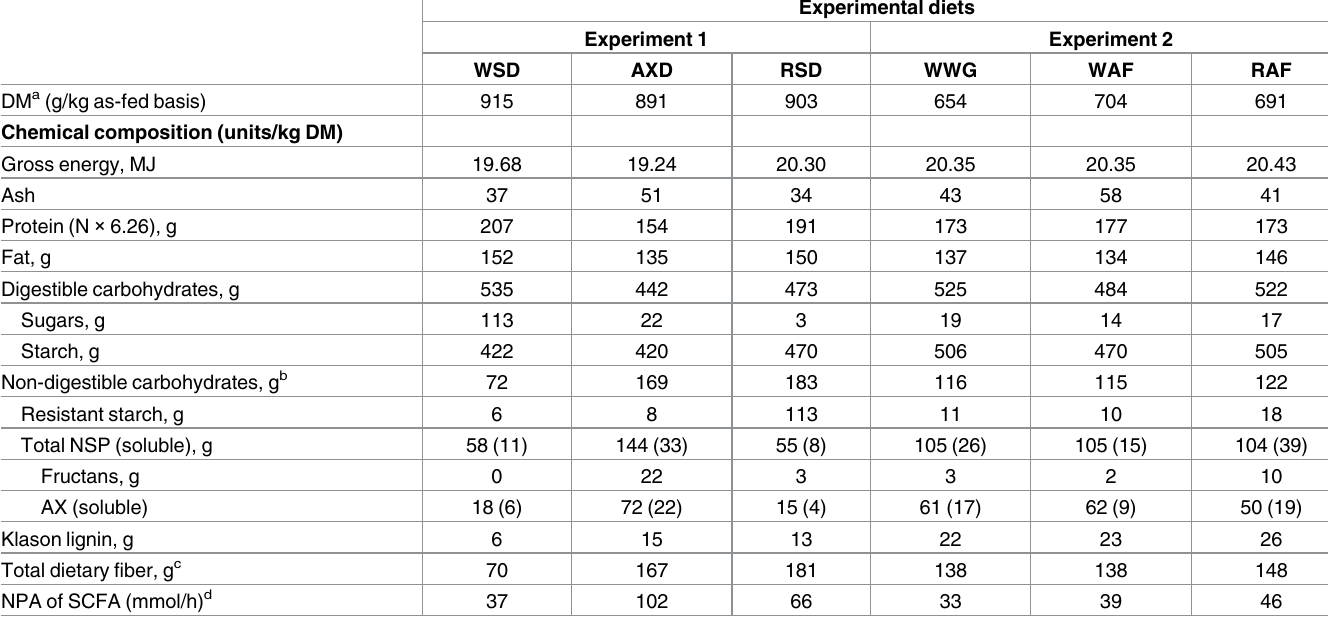
Table 1. Chemical composition of the experimental diets and postprandial net portal appearance of total SCFA after consumption of the experi- mental